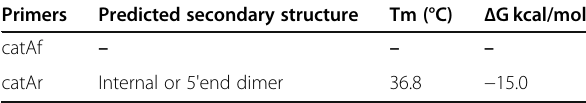
Table 5 Degenerate primer evaluation for secondary structure